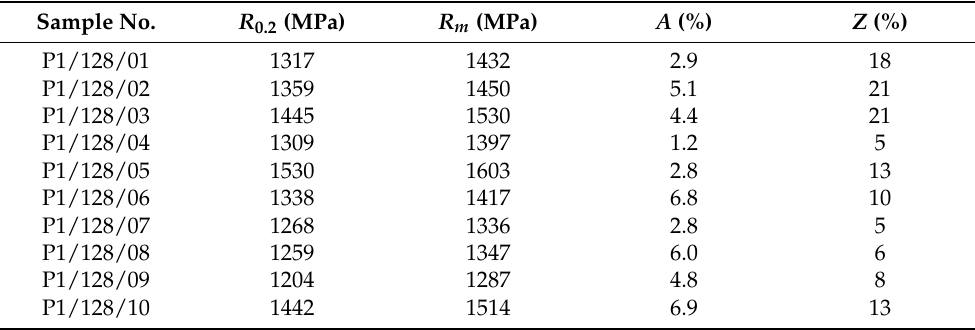
Table 2. Tensile testing